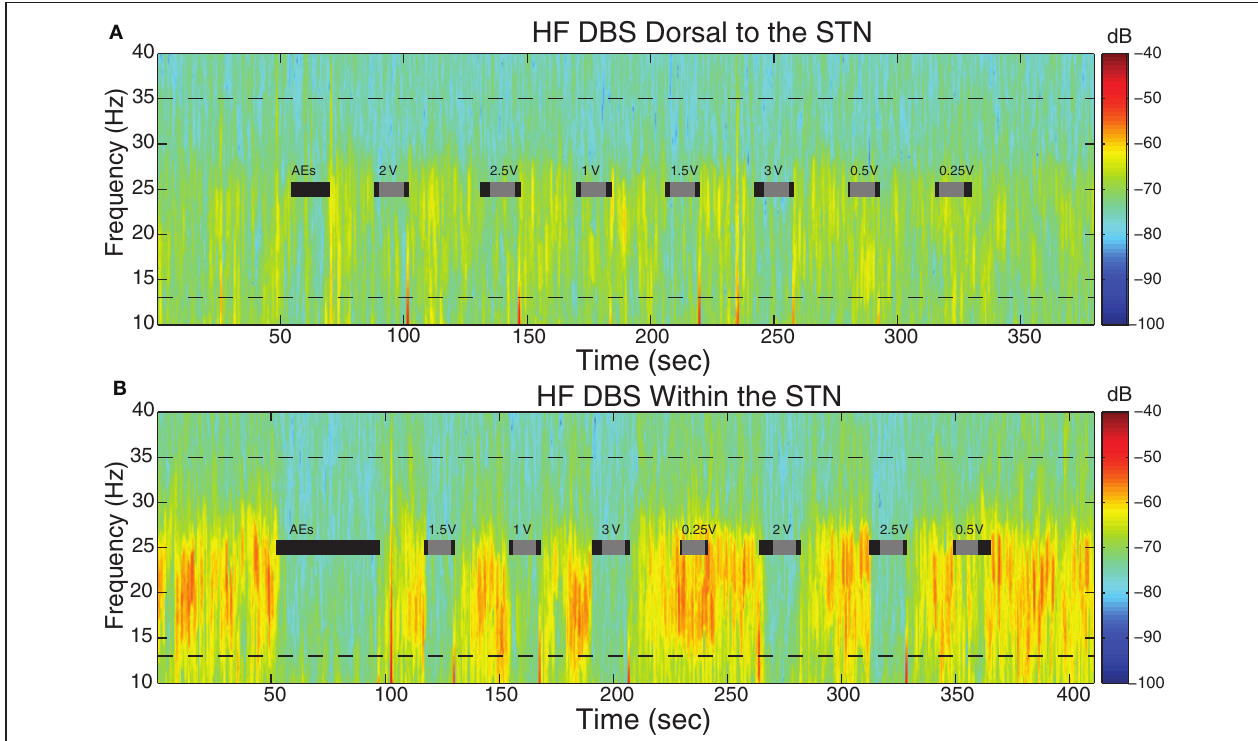
FIGURE 3 | Spectral dynamics of LFPs dorsal to and within the STN. Spectrogram of LFPs during DBS (A) 1.5mM dorsal to the dorsal border of the STN and (B) within the STN (2.25mM below dorsal border) from a representative patient (case 2L). Dotted lines demark the 13–35Hz limits. Gray bars indicate the 10s period of HF DBS used in beta power calculations, which excluded artifacts at the onset and offset of DBS, and black bars indicate the full time period that HF DBS was on. The bars marked “AEs” demark the period of time when HF DBS was increased from 0 to